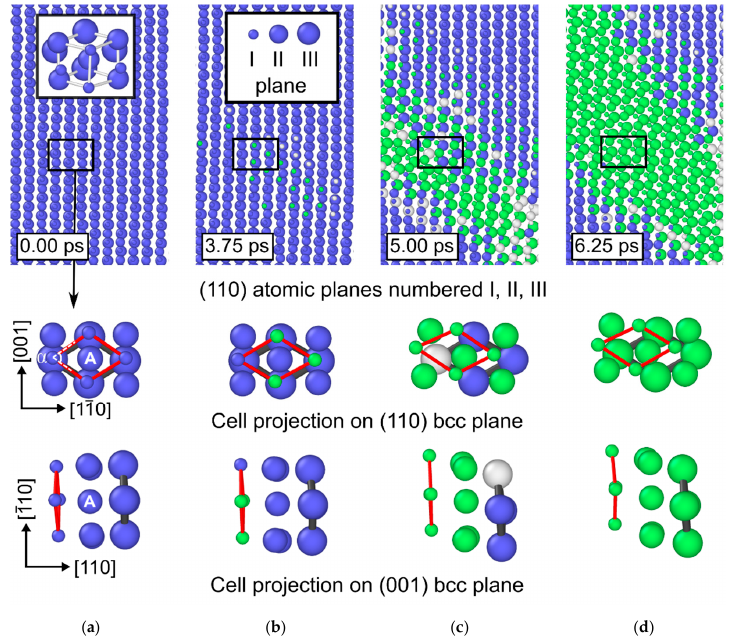
Figure 18. Three adjacent (110) planes (upper row) and projections of the analyzed cell around atom A onto the (110) plane (middle row) and the (001) plane (lower row) at the time instants 0.00 ( a ), 3.75 ( b ), 5.00 ( c ), and 6.25 ps ( d ). The size of atoms corresponds to their position in the bcc (110) planes numbered I, II, and III. Atoms with bcc, fcc, and uncertain nearest neighbor symmetry are shown in blue, green, and gray, respectively. The inset in ( a ) exhibits the initial 3D view of the analyzed atomic cell, where gray solid lines represent the edges of the bcc Bravais cell.